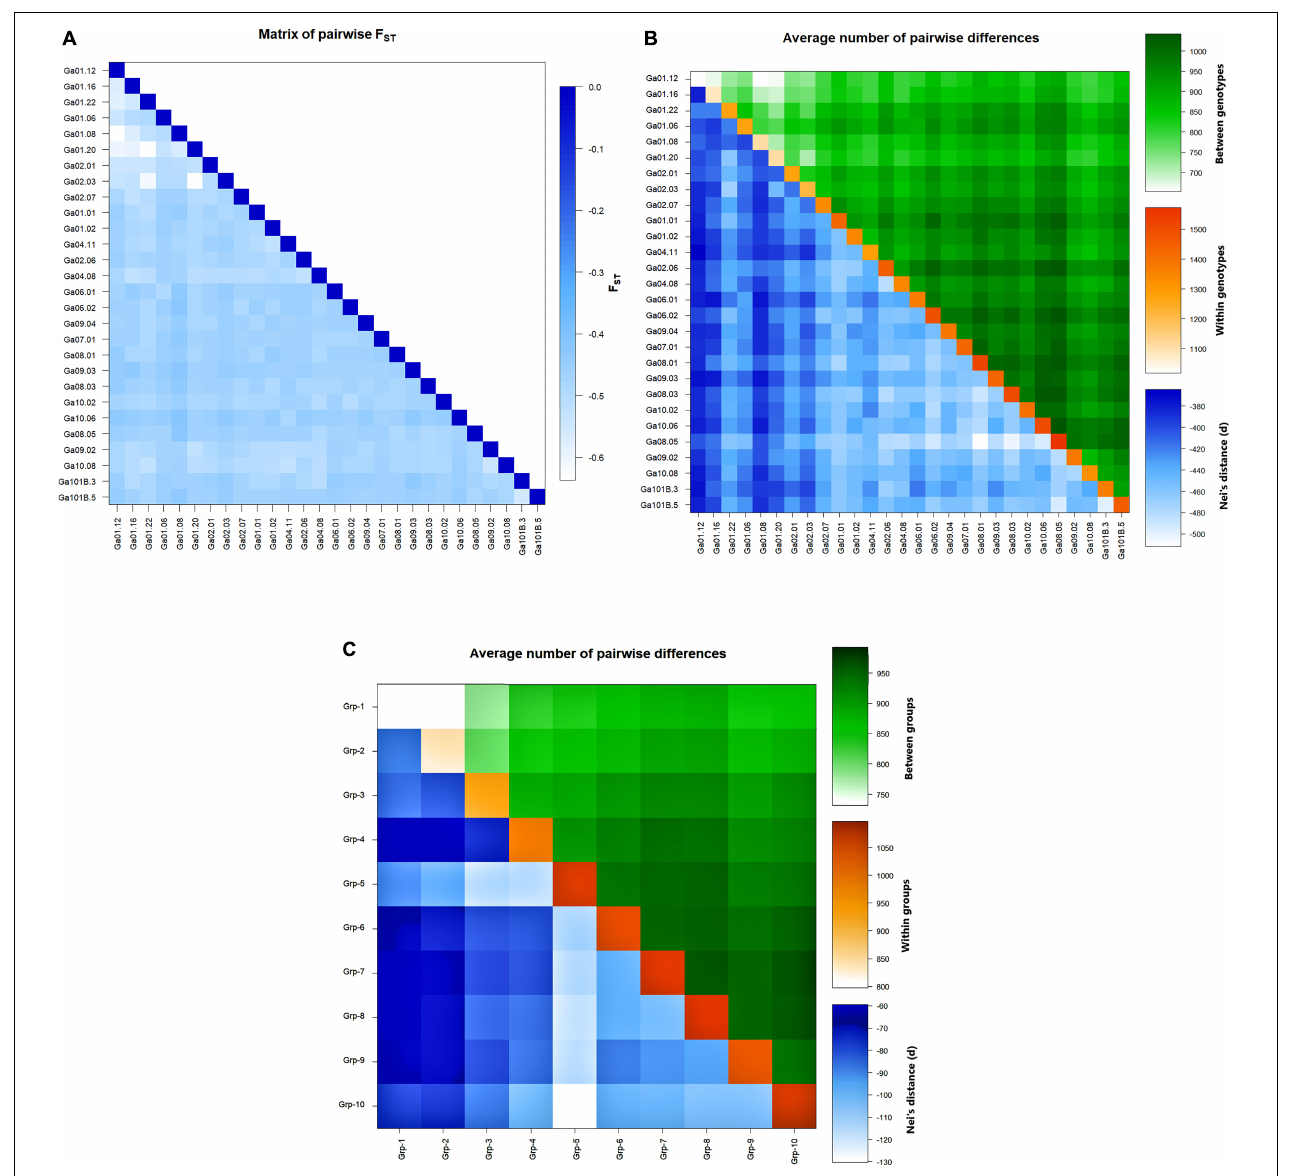
FIGURE 4 | Heatmaps of (A) pairwise F ST between the 28 genotypes, (B) average number of pairwise differences (above diagonal) and Nei’s distance (below diagonal) between the 28 genotypes, and average number of pairwise differences within the 28 genotypes (diagonal), and (C) average number of pairwise differences (above diagonal) and Nei’s distance (below diagonal) between the 10 groups of genotypes, and average number of pairwise differences within the 10 group of genotypes